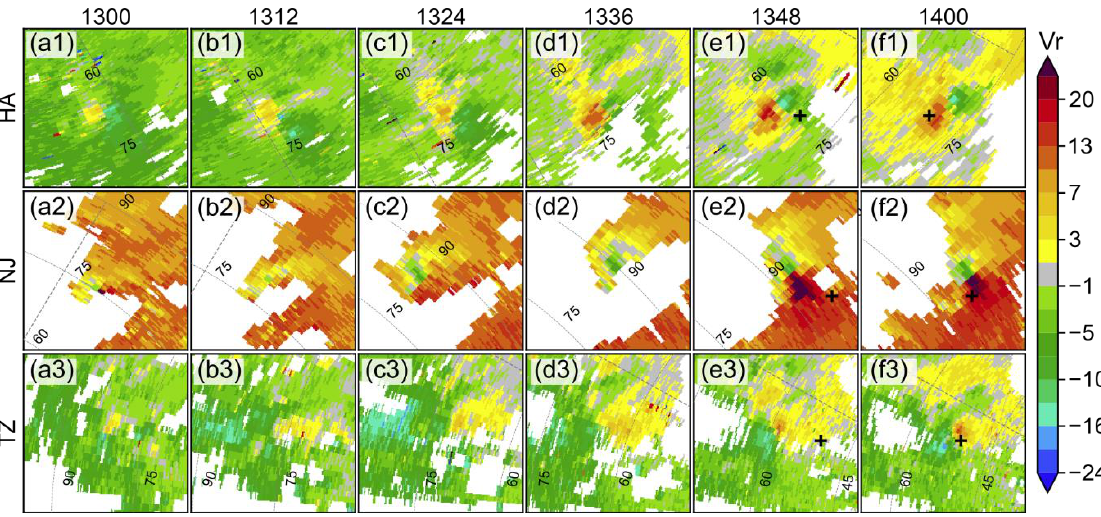
Figure 5. Radial velocity fields of the meso- γ supercell from 1300 to 1400 LTC. Each row ( 1 – 3 ) shows radial velocity fields from one radar at the 0.5 ◦ elevation angle, and each column ( a – f ) shows the supercell at a different time. The black cross in ( e – f ) represents the tornado